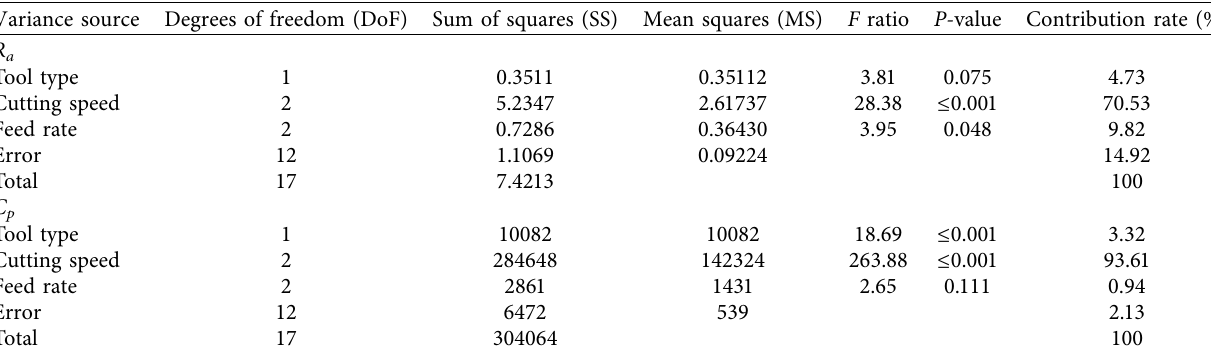
Figure 6: Effect of the cutting parameters on cutting power. Table 6: Surface roughness and cutting power ANOVA